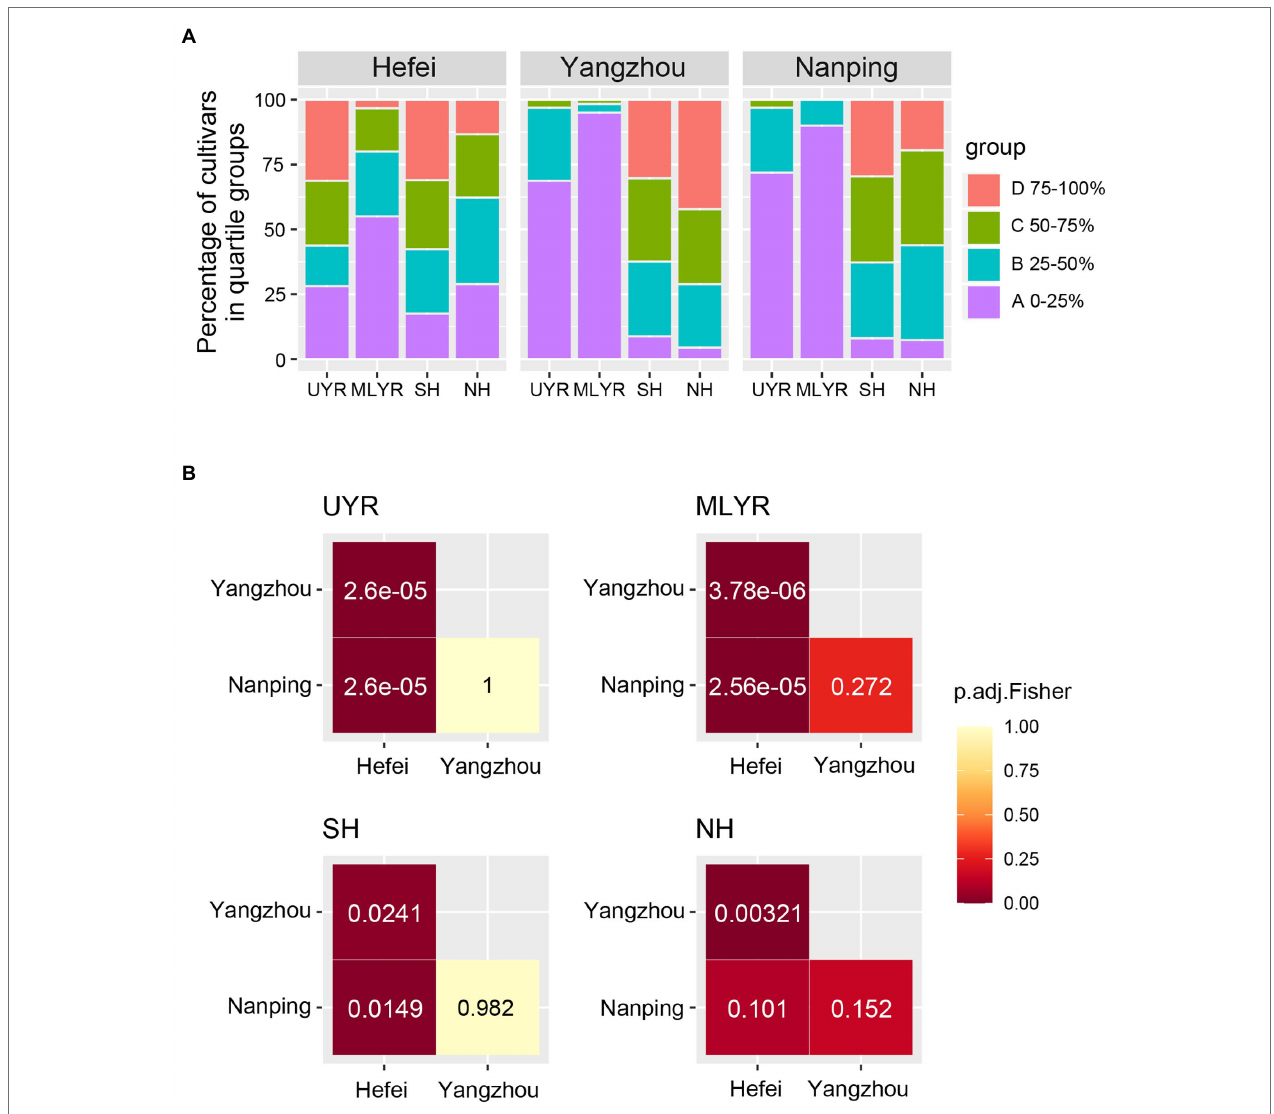
FIGURE 3 | Resistant composition based on quartile method for wheat cultivars from four ecological regions between three nurseries. (A) Distribution of quartile groups in each of the three nurseries (A: 0–25% of cultivars; B: 25–50% of cultivars; C: 50–75% of cultivars; D: 75–100% of cultivars); (B) Fisher’s exact test of composition of quartile groups between three